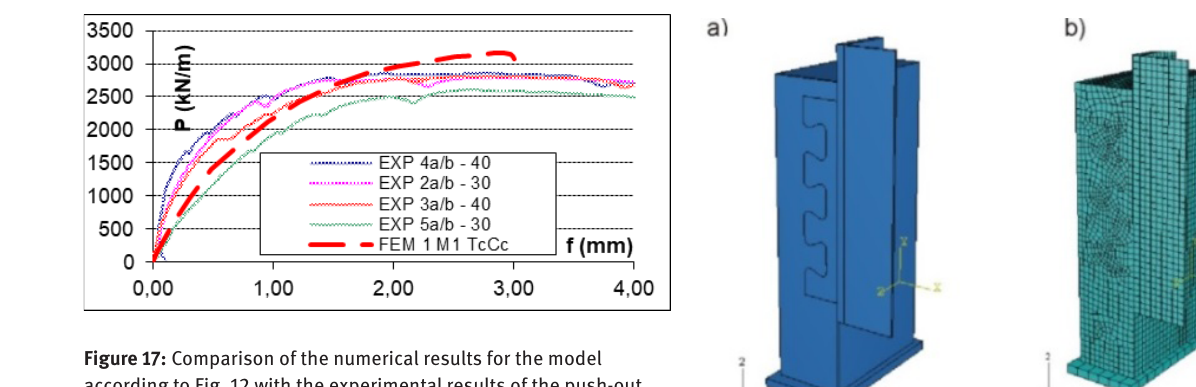
Figure 17: Comparison of the numerical results for the model according to Fig. 12 with the experimental results of the push-out tests according to [51,30].